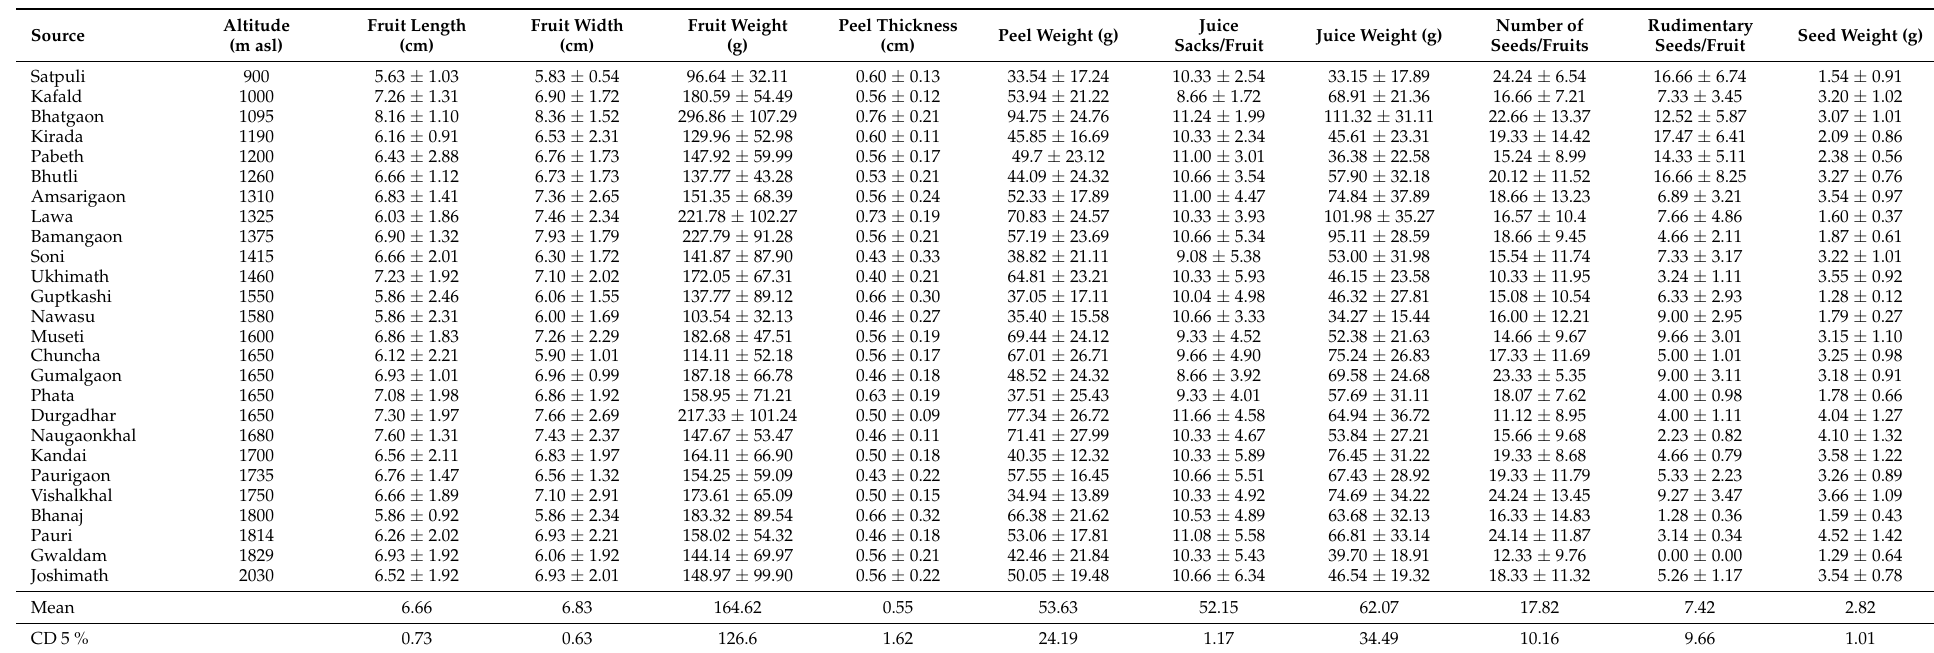
Table 2. Effect of altitude on fruit morphology (mean ± SD) of C. sinensis in Garhwal